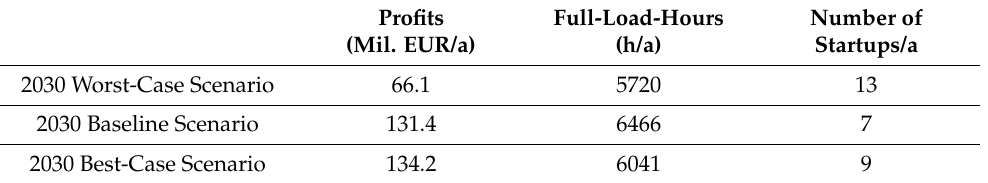
Table 6. Annual operating results of the power plant without TES.